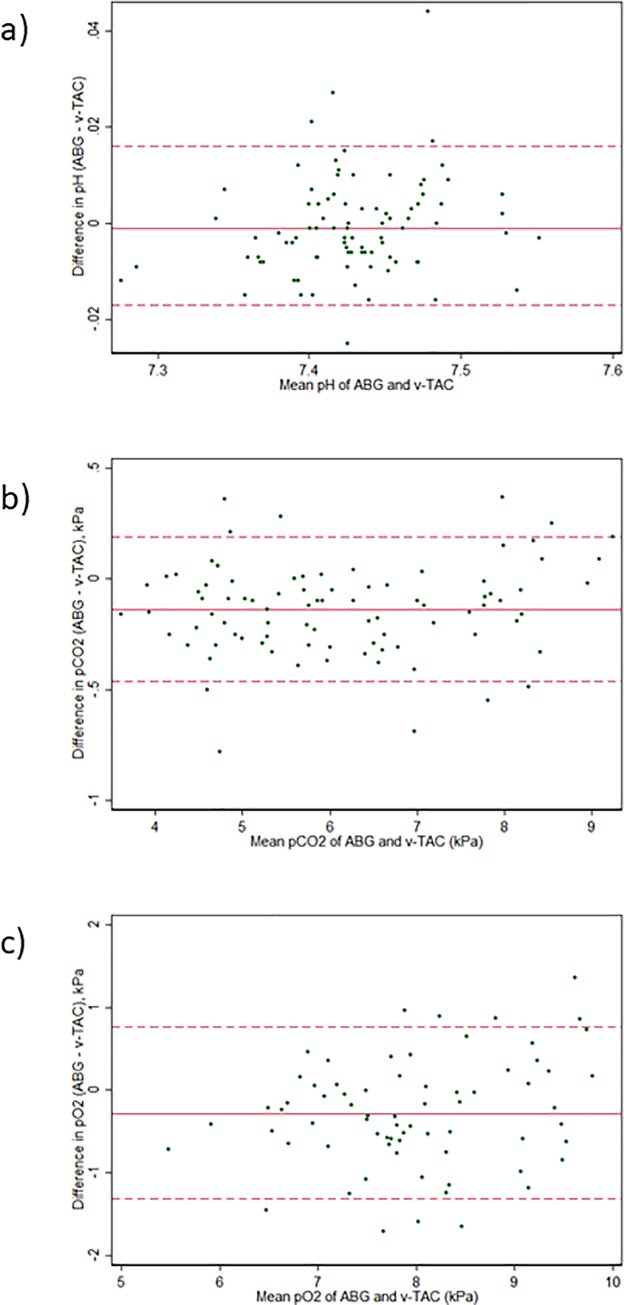
Bland Altman plots of agreement.Mean difference (solid line) with 95% limits of agreement (dashed lines), adjusted for repeated assessments (87 measurements in 46 patients). Agreement is shown for v-TAC vs. ABG regarding a) pH; b) pCO2; c) pO2.